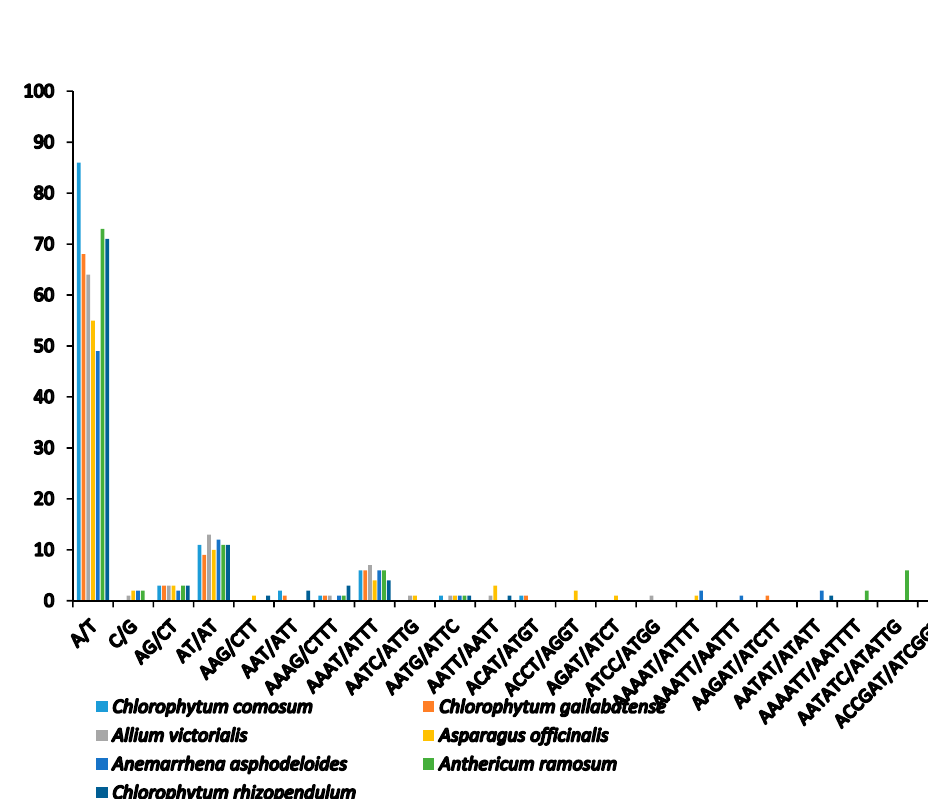
Figure 3. Number of different types of SSRs.